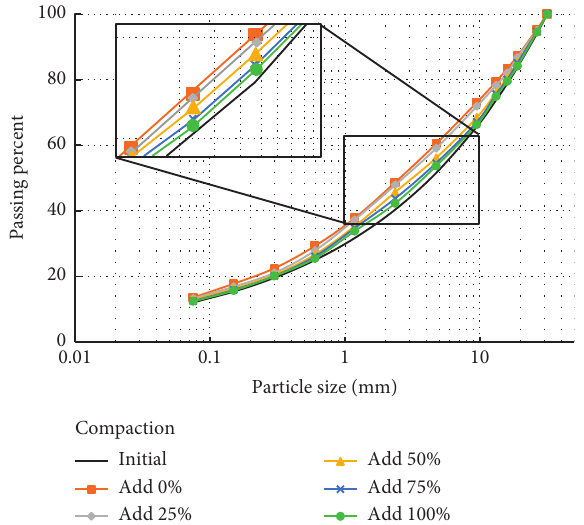
Figure 3: Particle breakage after impact compaction for Gradation